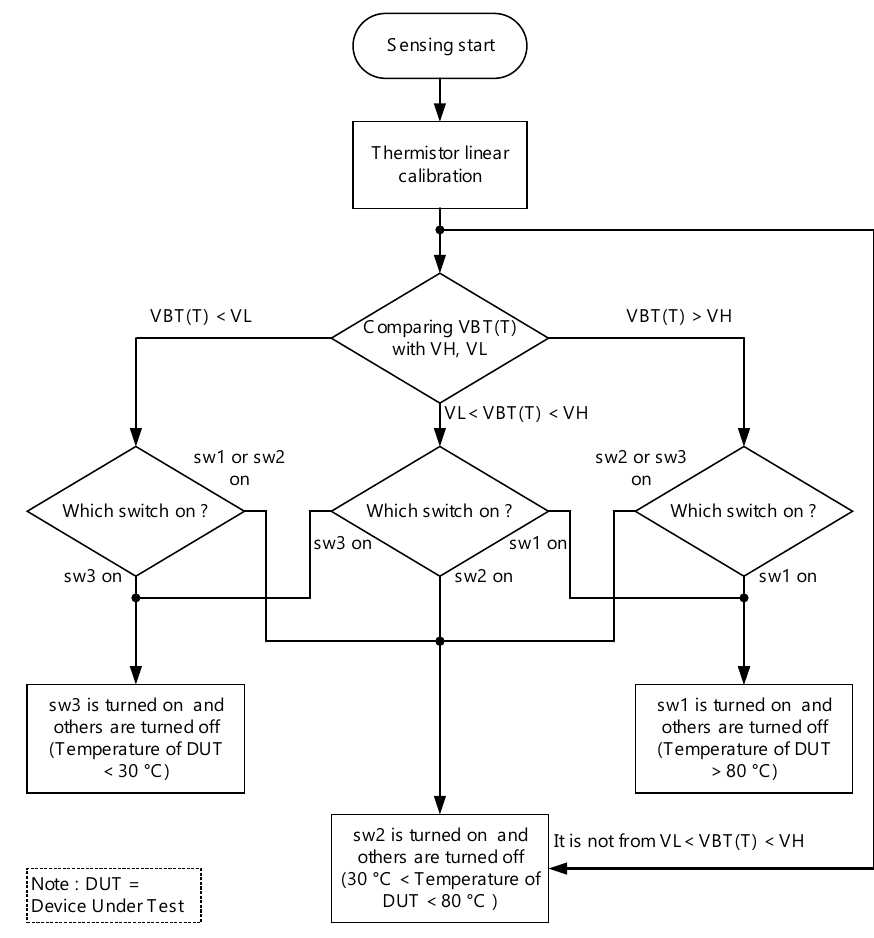
Figure 6. The flowchart of temperature range auto-selecting circuit (TRASC).